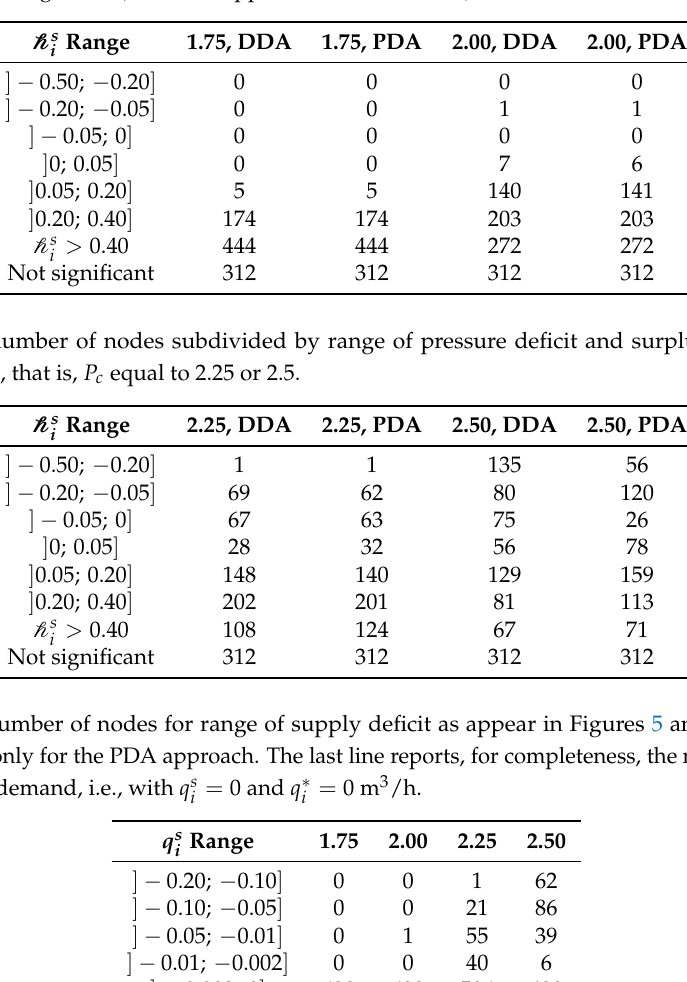
Table 2. The number of nodes in deficit or surplus pressure condition for each of the ranges used in Figures 4 and 6. The second column, for example, reports the number of nodes in any range, with reference to Figure 4a (i.e., DDA approach with P c = 1.75).